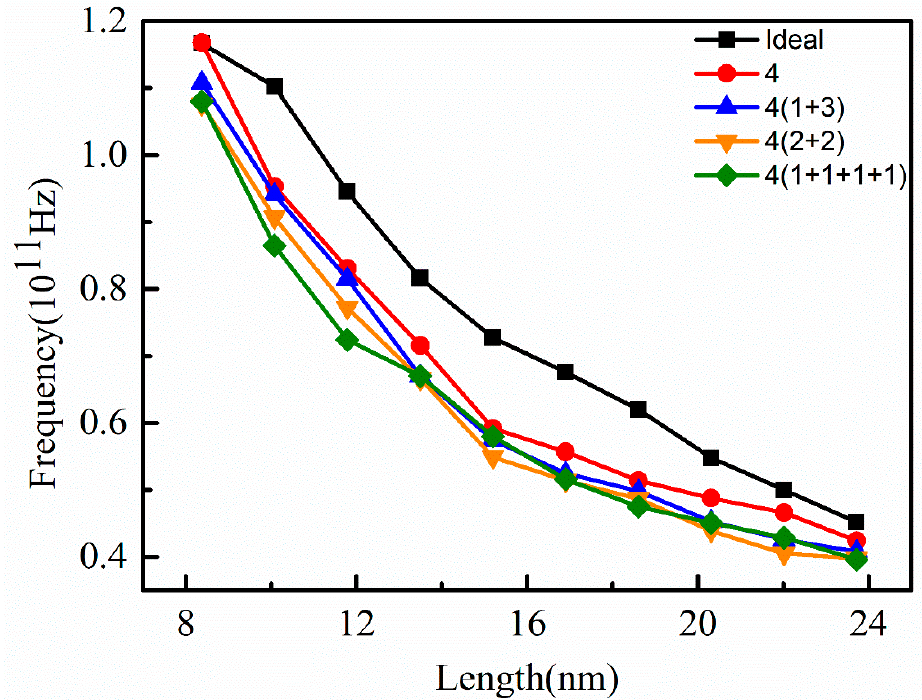
Figure 6. Variation of vibration frequency of graphene nanoribbon at different vacancy positions (V-4) with length.